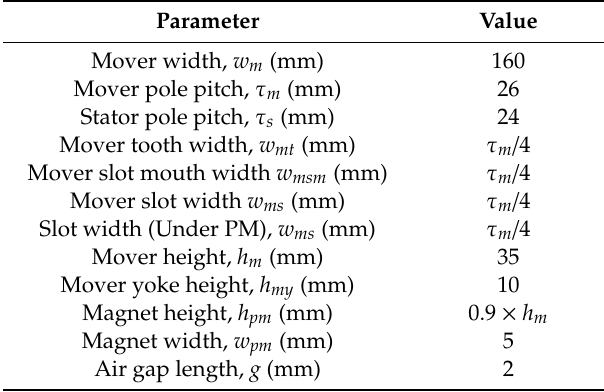
Table 3. Parameters of